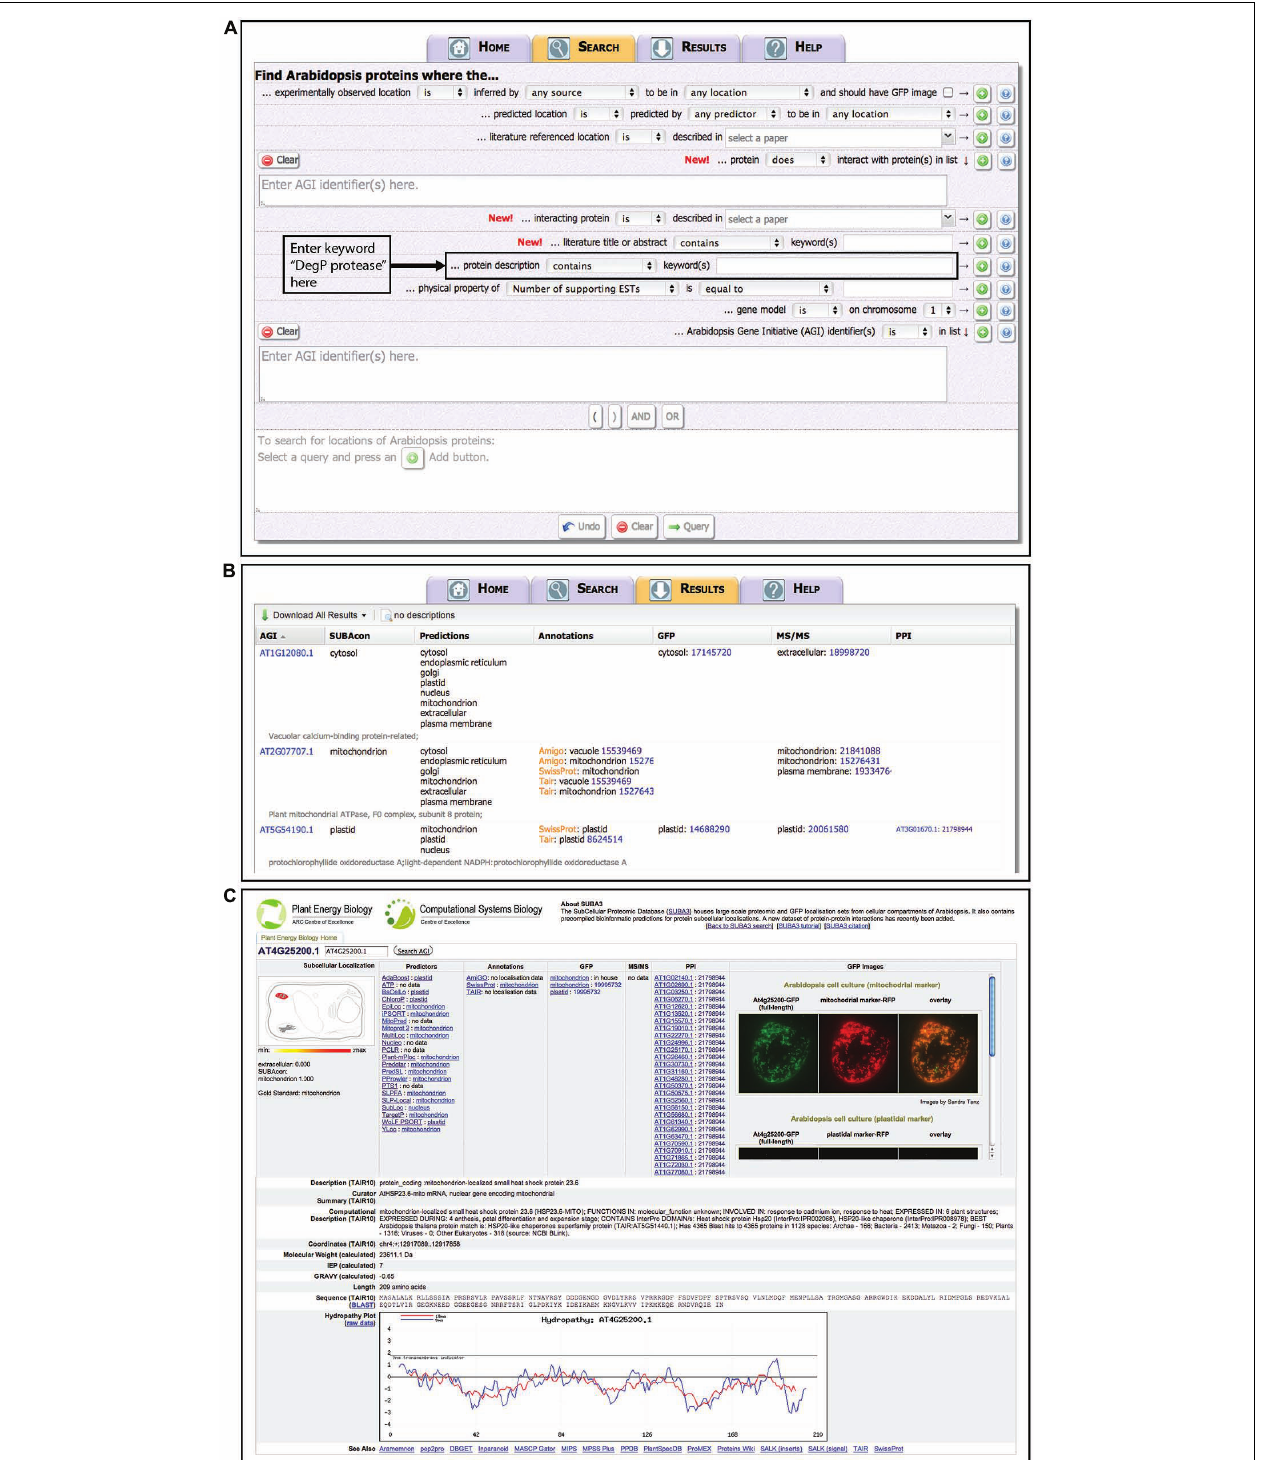
FIGURE 1 |The SUBA3 interface. Screenshots showing the SUBA3 search page (A) where complex queries can be build using pull down menus in combination with AND, OR, and bracketing functions.The SUBA3 Results page (B) of a query is shown with seven default columns and a “Download All Results” button in the left top corner. An example of a SUBA3 flatfile (C)